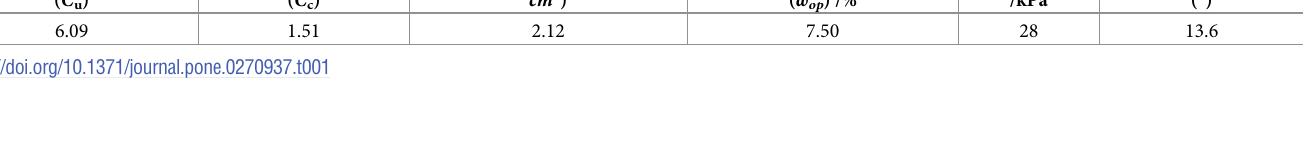
Table 2. Description of three working conditions.